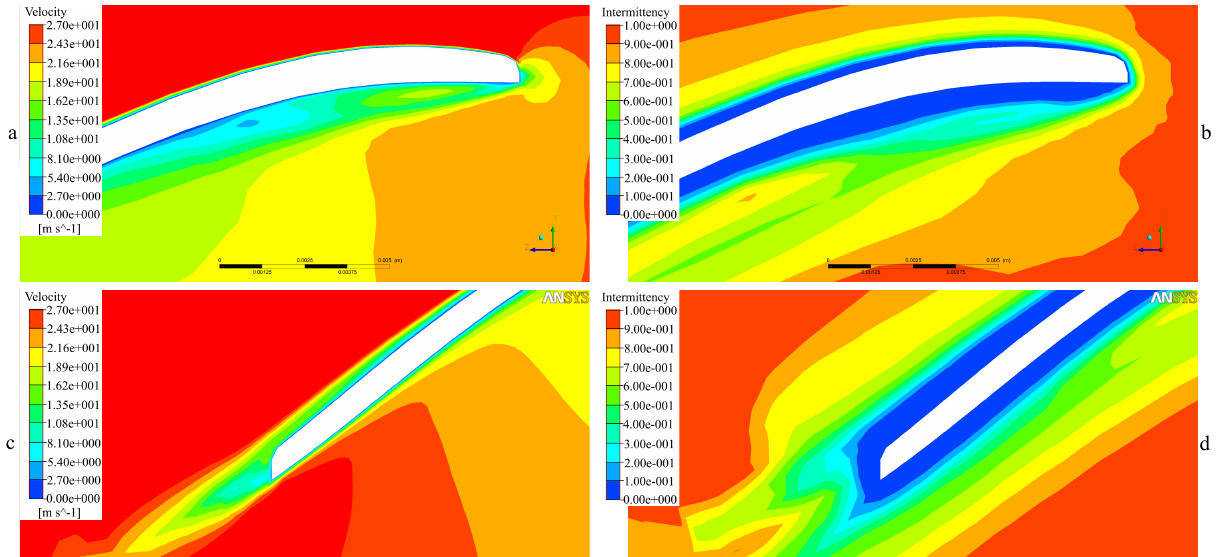
Figure 14. Velocity and intermittency contours at the root for operation at Re = 1.15 × 10 5 . ( a ) Ve- locity at the leading edge, ( b ) intermittency at the leading edge, ( c ) velocity at the trailing edge, ( d ) intermittency at the trailing